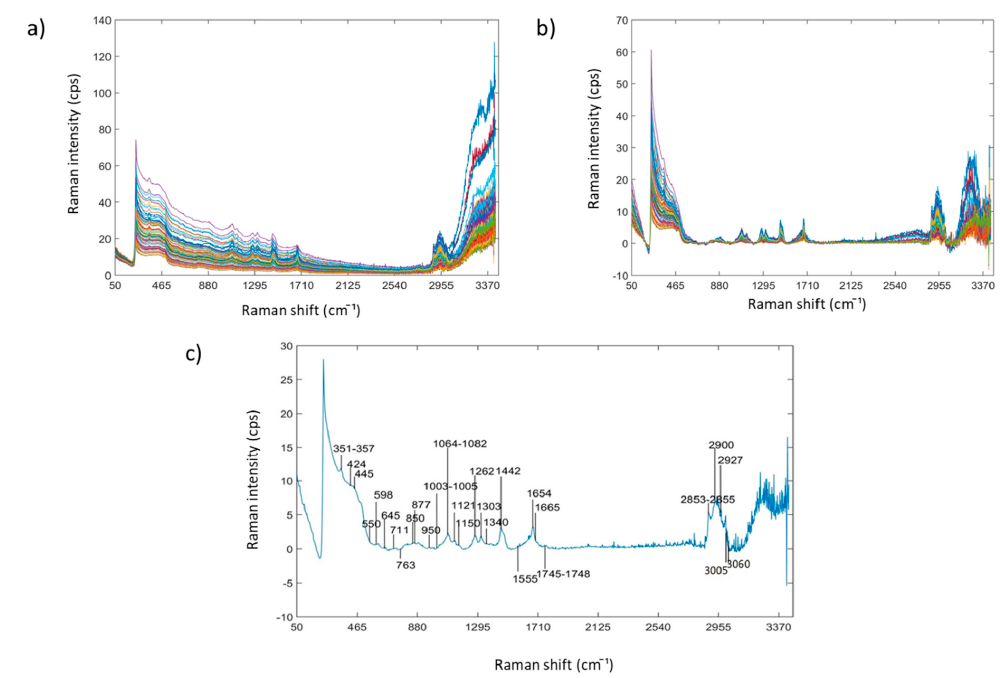
Figure 1. ( a ) Raw Raman spectra in 50–3398 cm − 1 of all aqueous INF samples ( n = 83); ( b ) Raman spectra in 50–3398 cm − 1 pre-treated by AsLs baseline correction; ( c ) Averaged Raman spectrum in 50–3398 cm − 1 pre-treated by AsLs baseline correction.